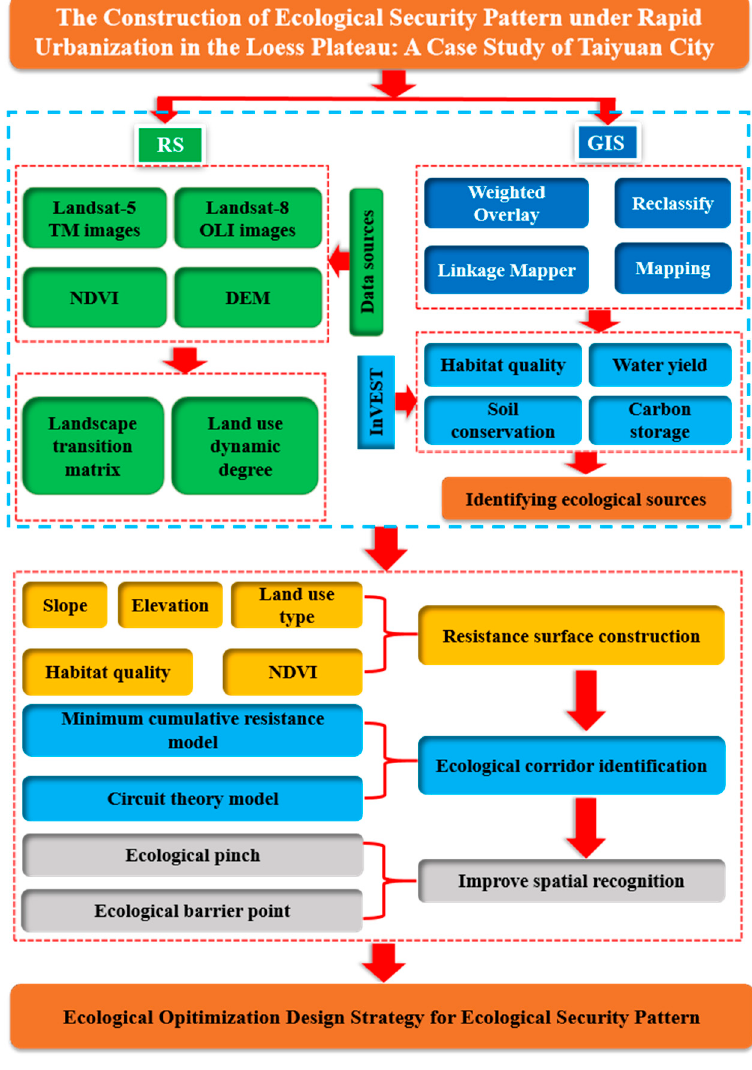
Figure 2. Map of the ESPs construction.